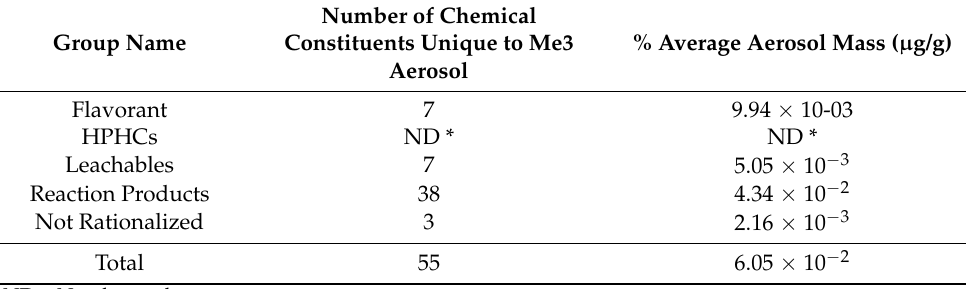
Table 6. Number of chemical constituents detected using the LC and/or GC NTA methods which are exclusive to JUUL Me3 aerosol compared to cigarette